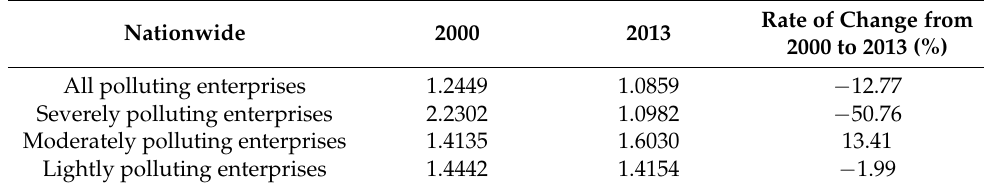
Table 4. Transboundary pollution effects of various types of polluting enterprises and their rates of